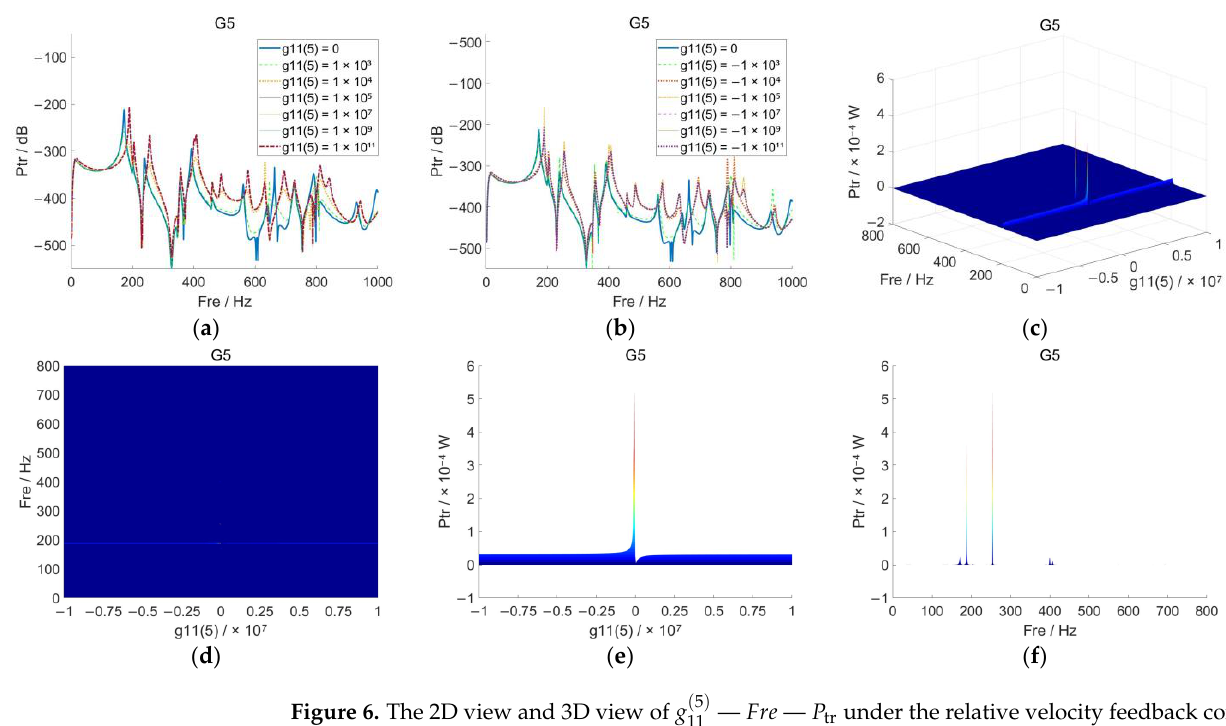
( 5 ) P under the relative velocity feedback control g — Fre — Figure 6. The 2D view and 3D view of ( ) 5 Figure 6. The 2D view and 3D view of g — Fre — P tr under the relative velocity feedback control 11 tr 11 ( 5 ) P curves under ( ) 5 0 g  ∈ (cid:0) − 10 7 , 10 7 (cid:1) , the step size is set to 1 × 10 4 ): ( a ) comparison of P tr curves under method ( ( ) ( ,  − , the step size is set to 1 × 10 4 ): ( a ) comparison of method ( g 11 tr 11 ( 5 ) > 0; ( b ) comparison of P tr curves under g ( 5 ) < 0; ( c ) the 3D view of P tr curve under continuous g P curves under ( ) 5 P curve under continuous variation 0 g  ; ( c ) the 3D view of ; ( b ) comparison of 11 11 11 tr tr ( 5 ) variation of g ; ( d ) X-Y plane view; ( e ) X-Z plane view; ( f ) Y-Z plane g ; ( d ) X-Y plane view; ( e ) X-Z plane view; ( f ) Y-Z plane view. of ( ) 5 11 11